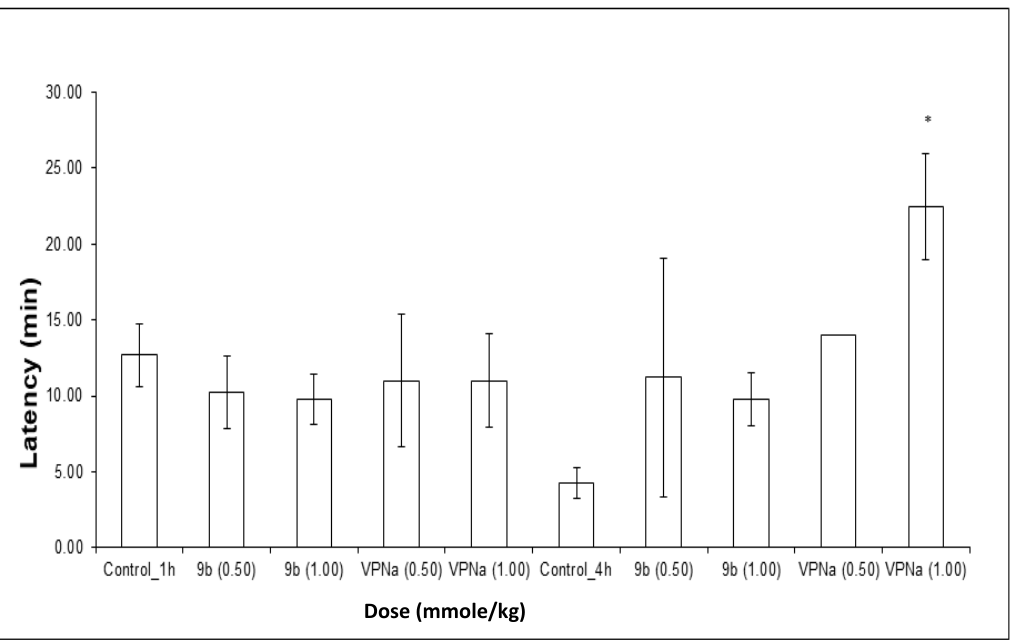
Figure 5. Latency of compound 9b compared to VPNa at different doses (0.50 and 1.00 mmole/kg) at 1 h and 4 h of pretreatment. * p < 0.05: Significant difference comparing control group with 9b and VPNa as a positive control group. Comparisons were made by the one-way ANOVA test Duncan’s means analysis test.